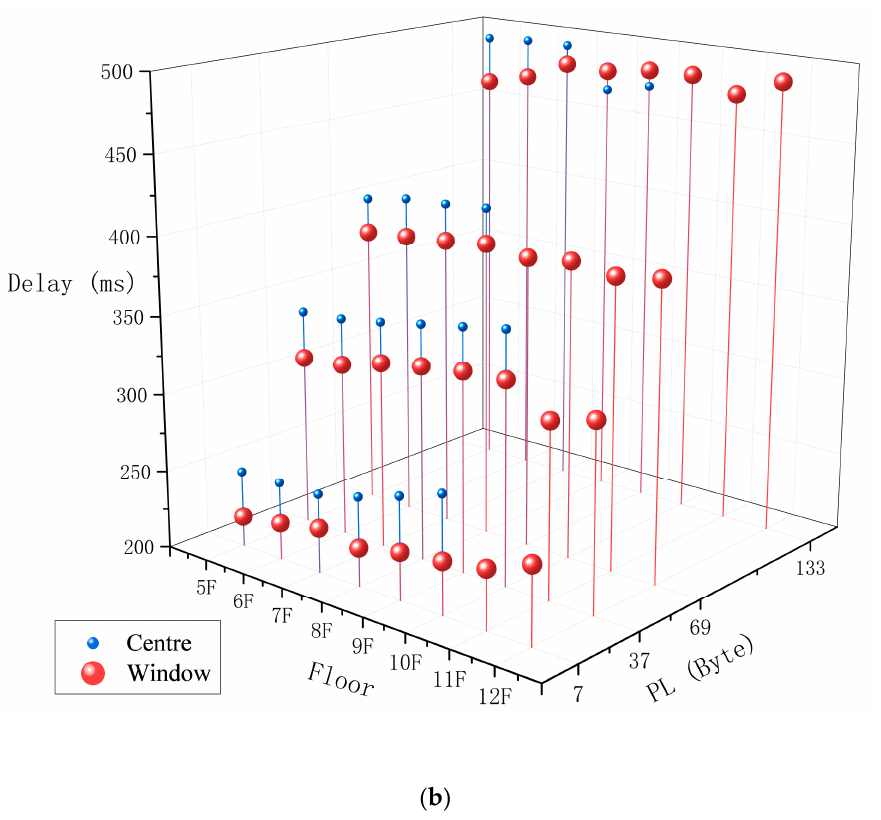
Figure 16. Comparison of RTT between central position and window position: ( a ) ZigBee; ( b ) LoRa.